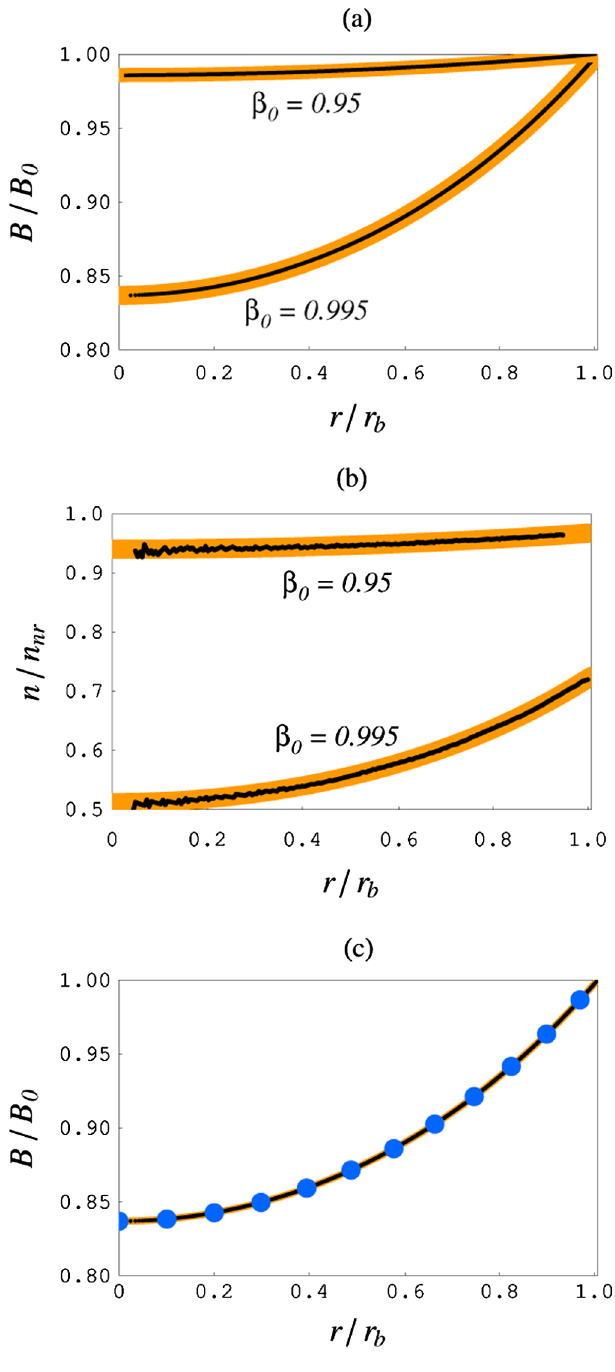
FIG. 1. Equilibrium in ultrarelativistic beams with K ¼ 0 : 003 . Panel (a) depicts the diamagnetic depletion of the focusing field B while panel (b) plots densities and reveals that particles migrate to higher radii. Relativistic effects are enhanced as velocities increase. In panel (c) we compare the curves of case ¼ 0 : 995 of panel (a) with the magnetic field calculated (cid:2) 0 according to Ref. [8] (filled circles) for the same parameters. ¼ 0 : 995 Þ and r =r ¼ Beam terminus at r b =r nr ¼ 1 : 27 ð (cid:2) b nr 0 ¼ 0 : 95 Þ , common values determined both from simu- 1 : 024 ð (cid:2) 0 lations (thin lines) and analytics (thick lines). In panel (c) thinner lines are employed for better